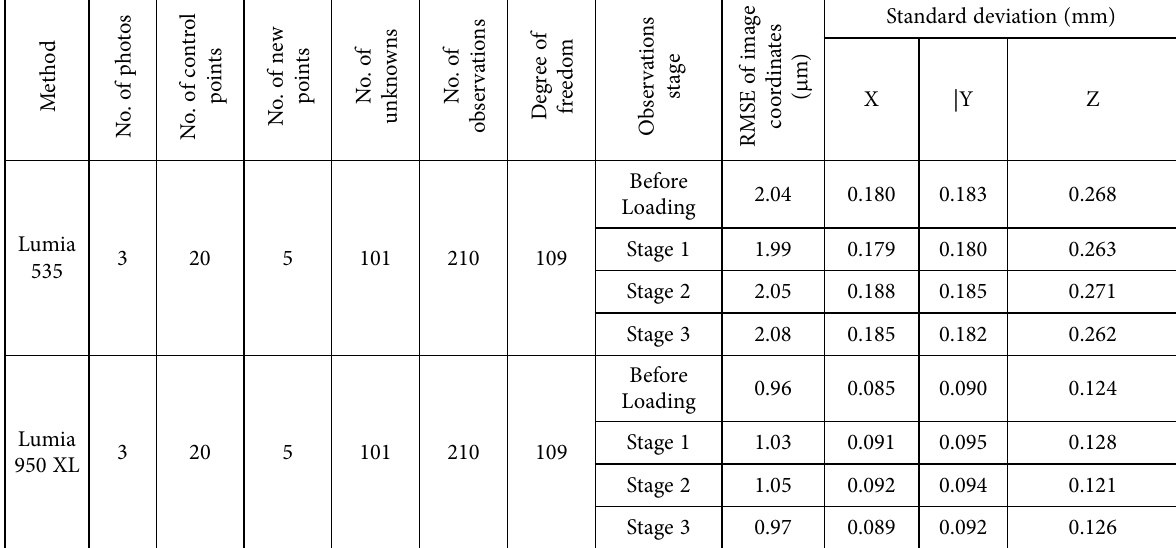
Table 2. The results of simultaneous self calibration block adjustment